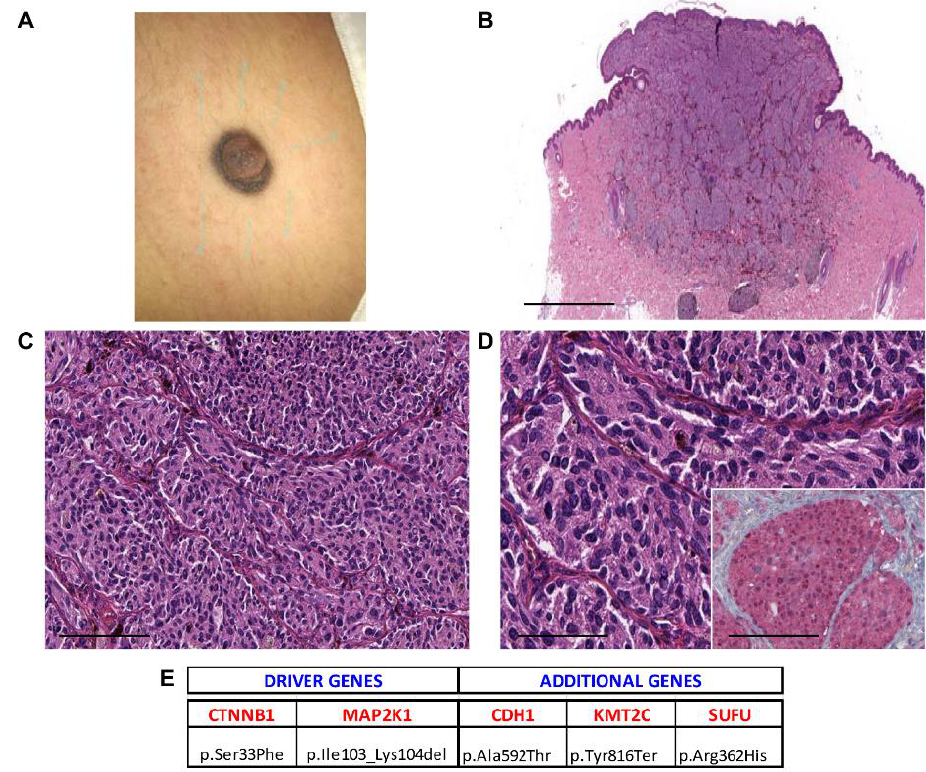
Figure 2. Case 3—female, 19 years old, back. ( A ) Clinical image showing a dome-shaped pigmented nodule on the back; ( B ) highly cellular dermal-based proliferation with a deep wedge-shaped configuration (40 × , scale bar 500 µ m); ( C ) scattered melanophages admixed with melanocytes (200 × , scale bar 50 µ m); ( D ) enlarged, hyperchromatic nuclei (400 × , scale bar 25 µ m). Inset: β -catenin immunohistochemical expression at nuclear level (400 × , scale bar 25 µ m). ( E ) Mutational profile: driver gene mutations and additional pathogenic alterations.